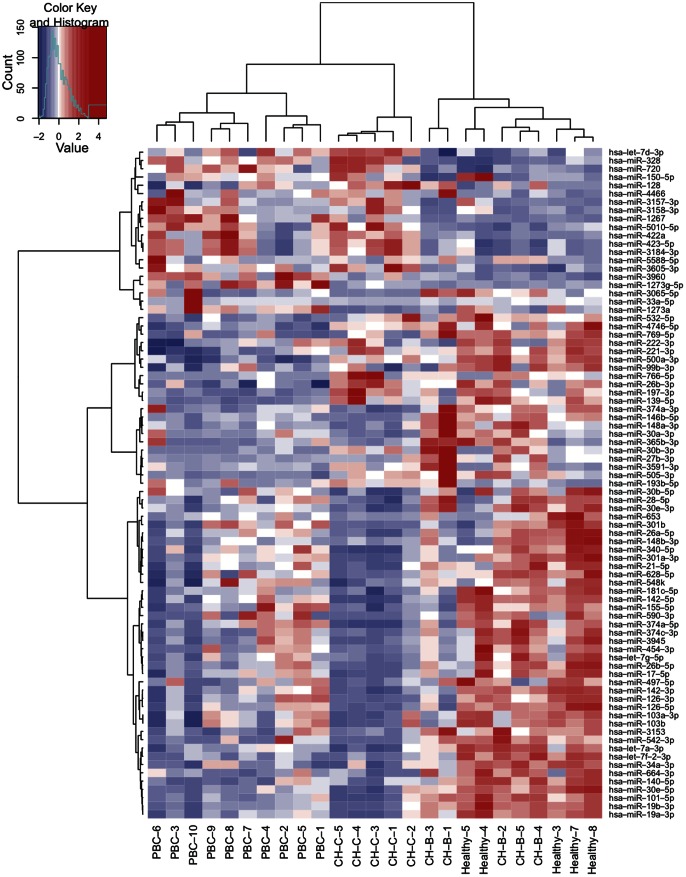
Heat map and hierarchical clustering.Individual miRNA expression were calculated by R platform and heat map was computed and described using a function of heatmap.2 in gplots. It uses hierarchical clustering with Euclidean distance; Pearson Linear Correlation and Ward's method to generate the hierarchical tree [56]. ANOVA was applied to extract differentially expressed miRNAs and adjustment of the p-value by multiple comparisons was performed by calculating FDR. Those miRNAs with FDR<0.1 were presented. The red indicates high level of miRNA expression and the blue shows low.